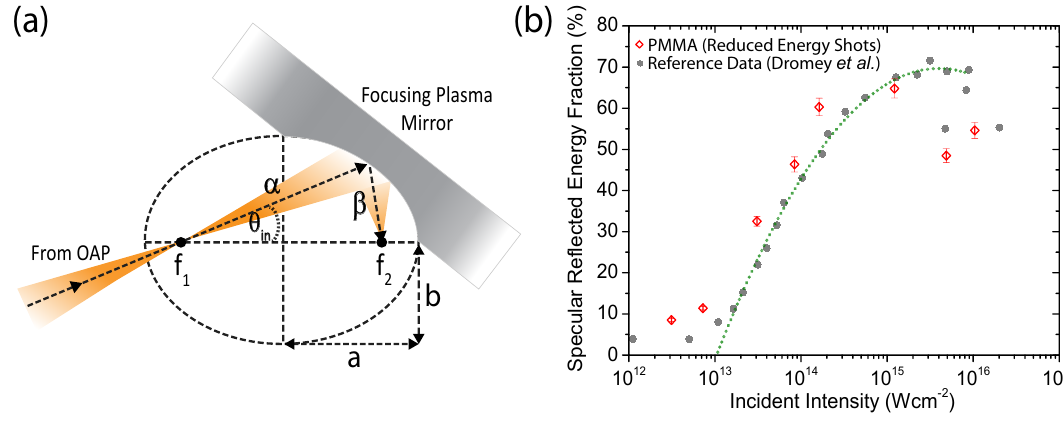
Figure 1. ( a ) Schematic illustrating the operation of an ellipsoidal focusing plasma mirror (FPM), where the incoming laser is focused by an off-axis parabolic (OAP) to position f 1 and the FPM re-focuses to position f 2 , with magnification given by β / α . ( b ) Percentage of laser light specularly reflected from a planar plasma mirror (PPM) as a function of the incident laser intensity. Red points correspond to measurements from reduced energy Vulcan-PW pulses on a flat PPM made from polymethyl methacrylate (PMMA), and grey points correspond to reference data, reported in Dromey et al. [18] (measured employing a 500 fs pulse and a fused silica PPM, with a 6 ◦ incidence angle). A quadratic fit is made to these data between 10 13 –10 16 Wcm − 2 , as illustrated by the dotted green